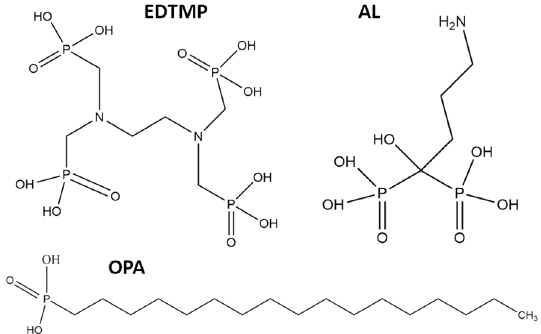
Figure 1. Chemical structures of ethylenediaminetetra (methylene phosphonic acid) (EDTMP), (4-amino-1- hydroxy-1-phosphonobutyl)phosphonic acid, also known as alendronic acid (AL), and octadecylphosphonic acid